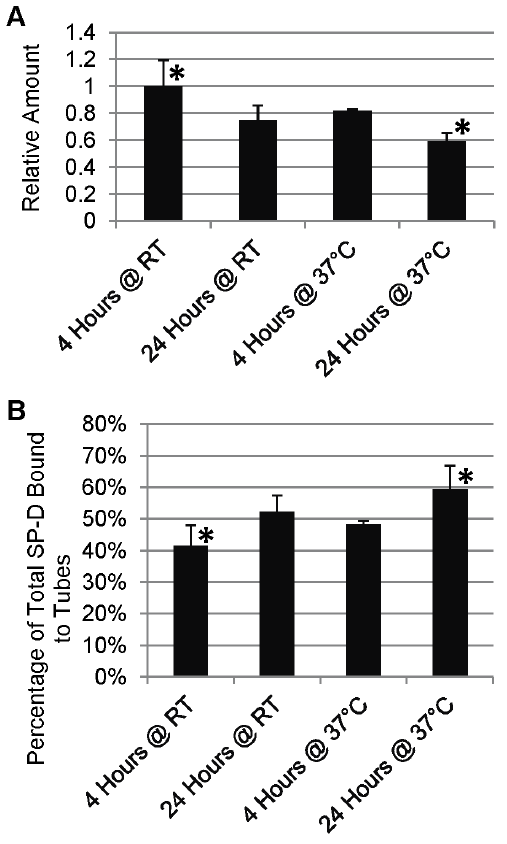
Figure 4. Depletion of SP-D during Extended Incubations. 5 m l aliquots were taken from SP-D solutions after incubating at the indicated time/temperature, analyzed by Western blot, and quantified using ImageJ software (A). Values were normalized to the average of the ‘‘4 hours @ RT’’ group. The SP-D content of tubes was analyzed and compared to the total amount of SP-D in the supernatant and tube (B). An asterisk (*) denotes p # 0.05 when comparing columns.